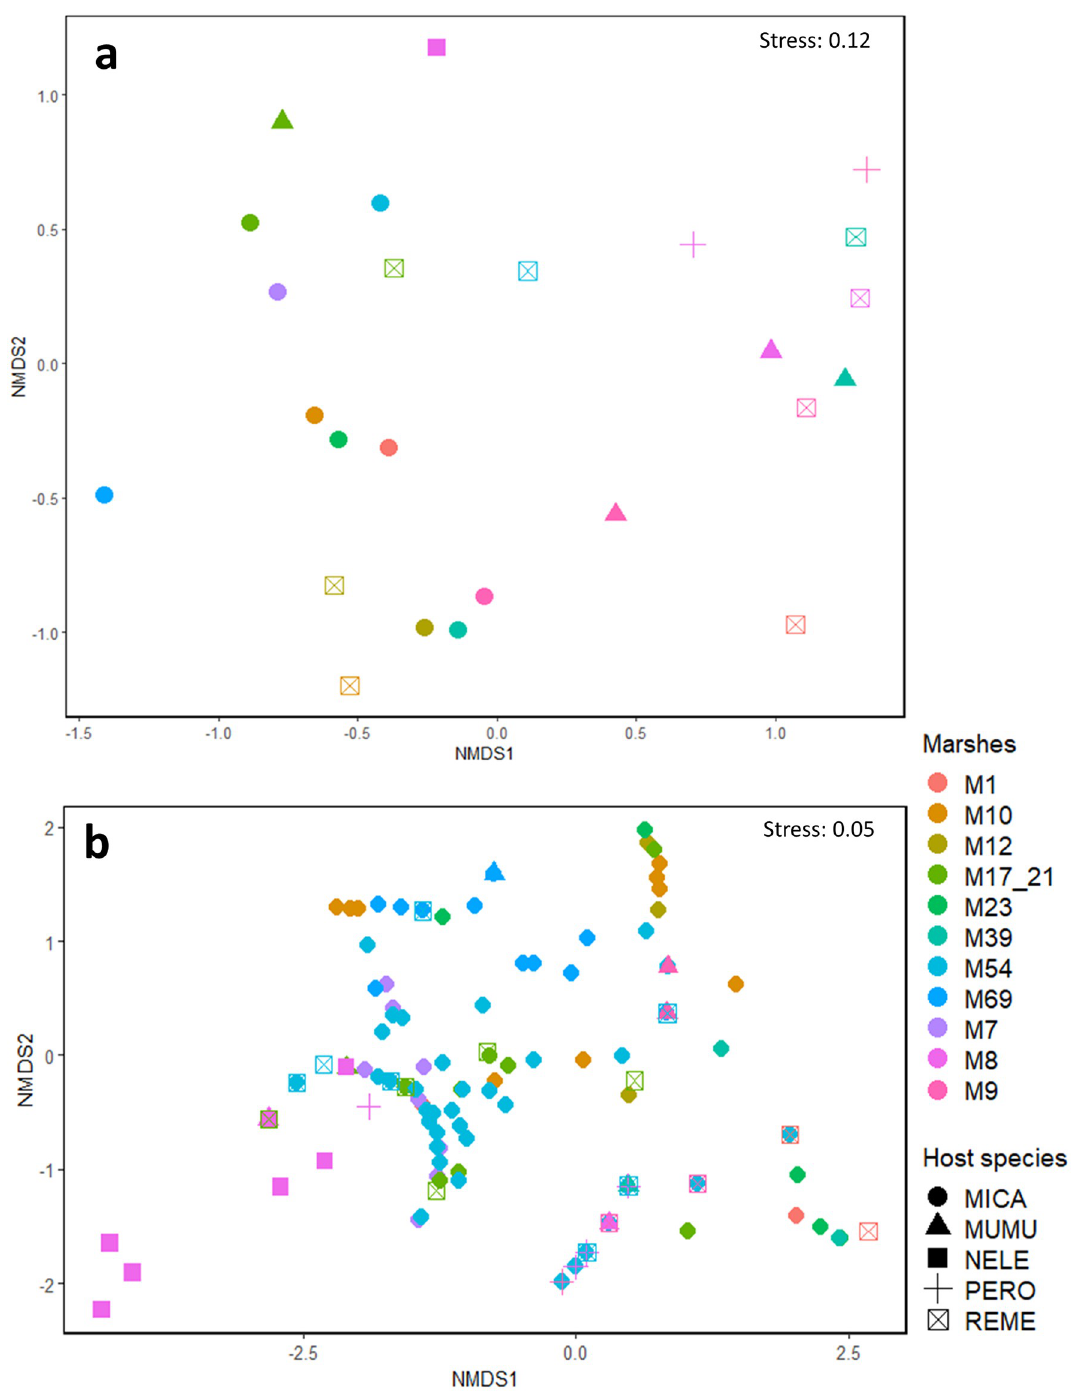
Fig 3. Non-metric multidimensional scaling (NMDS) plots of ectoparasite community. Ectoparasite component communities (3a) and infracommunities (3b) of rodents from 11 marsh patches in Tecopa, California, US. Host species: MICA, Microtus californicus scirpensis ; MUMU, Mus musculus ; NELE, Neotoma lepida ; PERO, Peromyscus eremicus ; REME, Reithrodontomys megalotis .